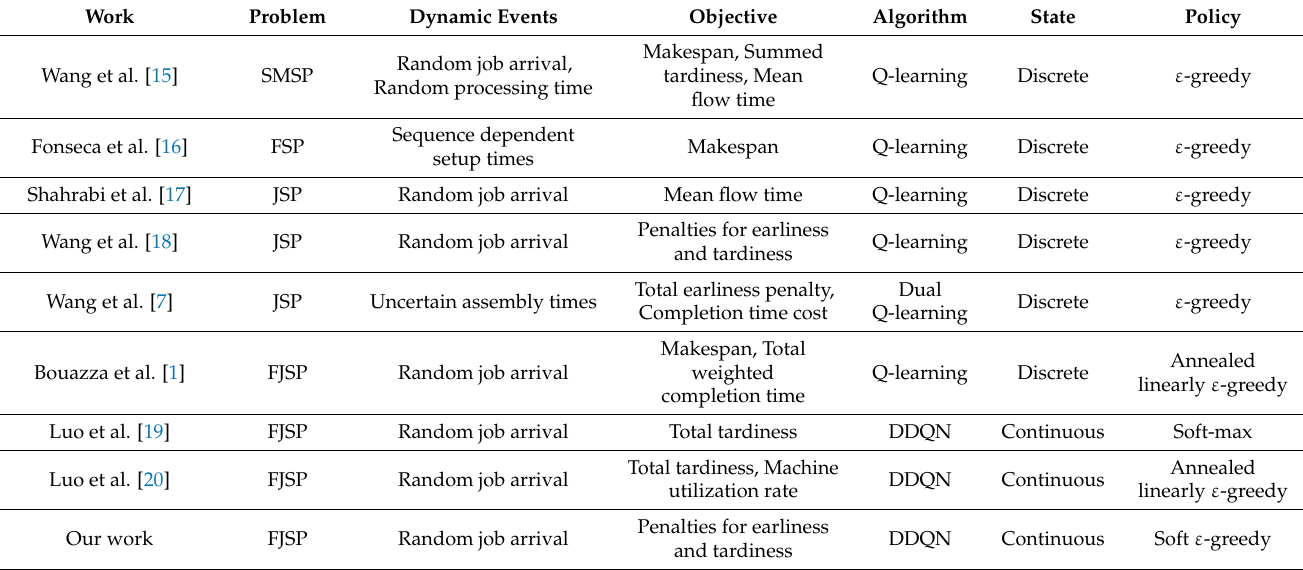
Table 1. Existing RL methods for dynamic scheduling